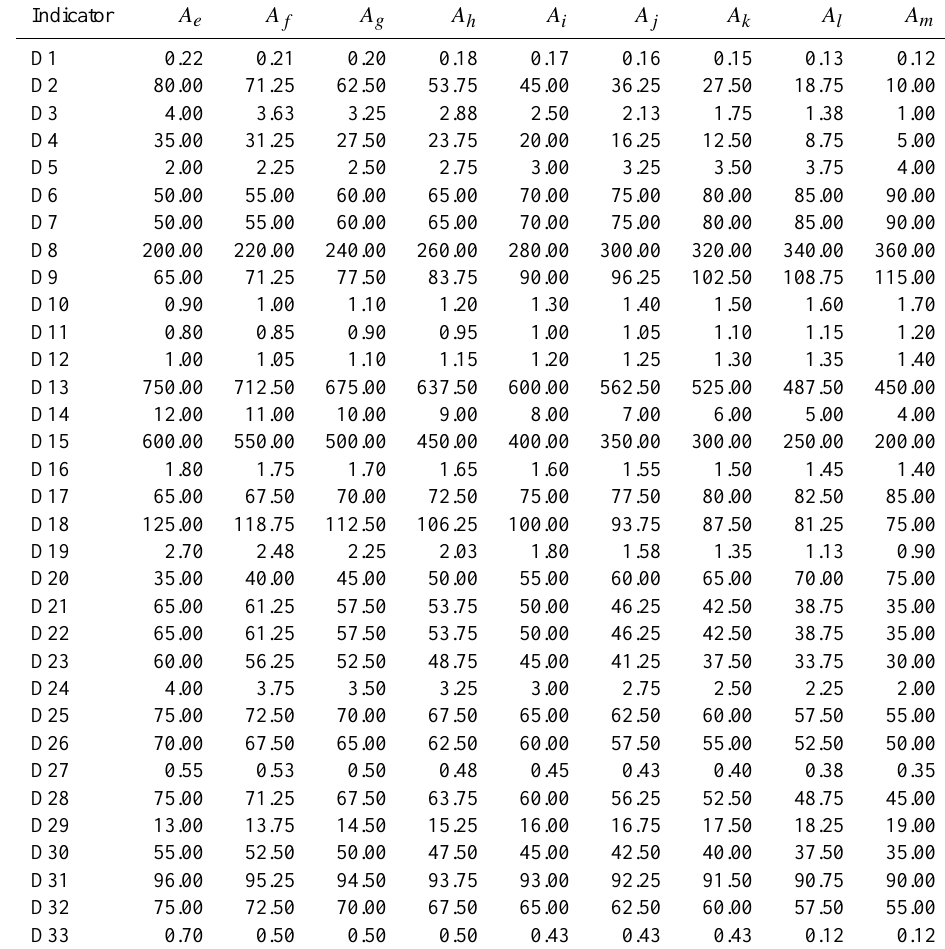
Table 6. Indicator value of nine standards in the water resources security evaluation system in the Yellow River basin.